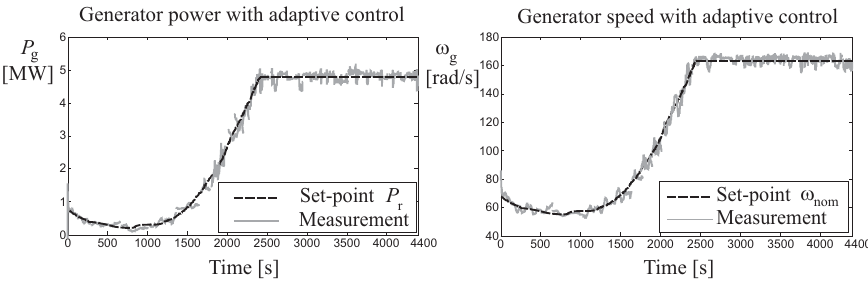
Figure 8. P g and ω g tracking capabilities in partial and full load conditions with the adaptive controllers.